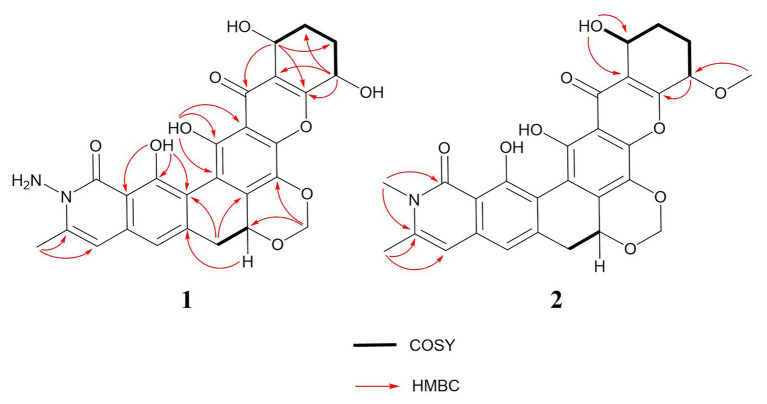
1H-1H COSY and key HMBC correlations of compounds 1 and 2.